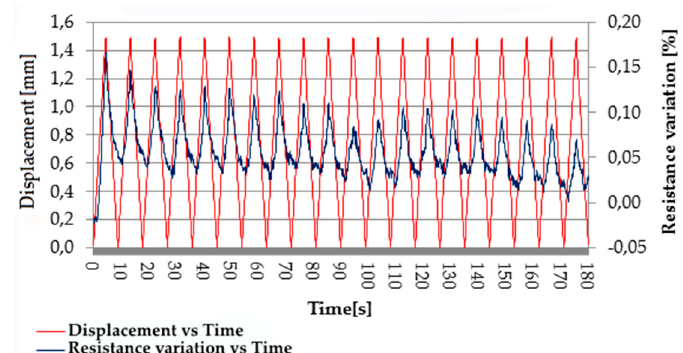
Figure 6. Piezoresistive behavior of EPDM/PP/4 wt.% CNT composite: cyclic resistance variation due to cyclic deformation from 0 to 1.5 mm.